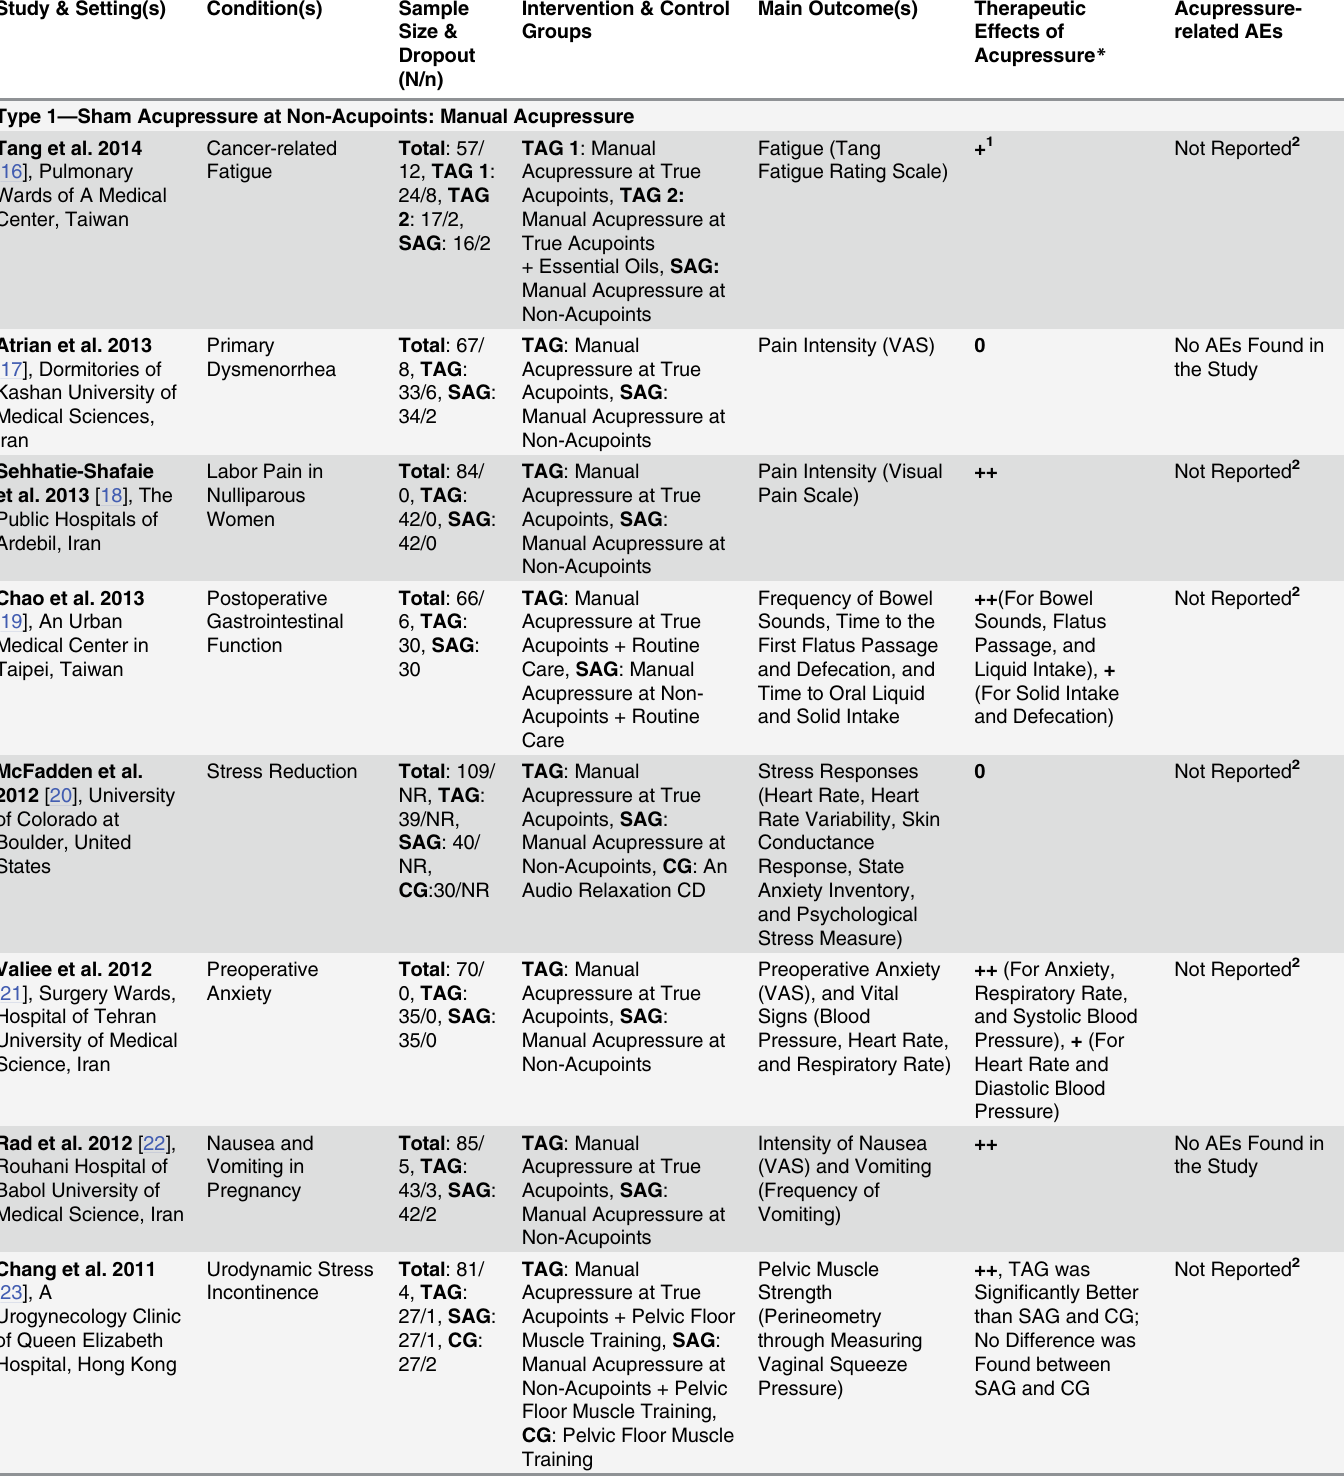
Table 2. Characteristics of the Included